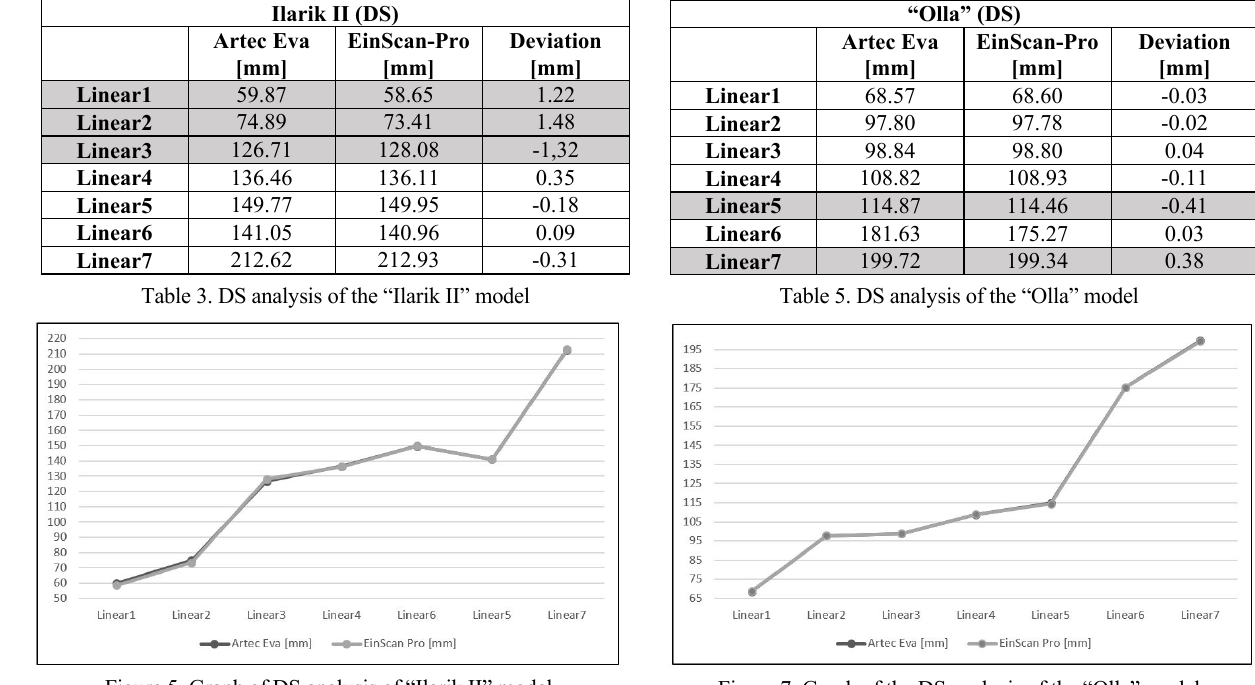
Figure 7. Graph of the DS analysis of the “Olla”